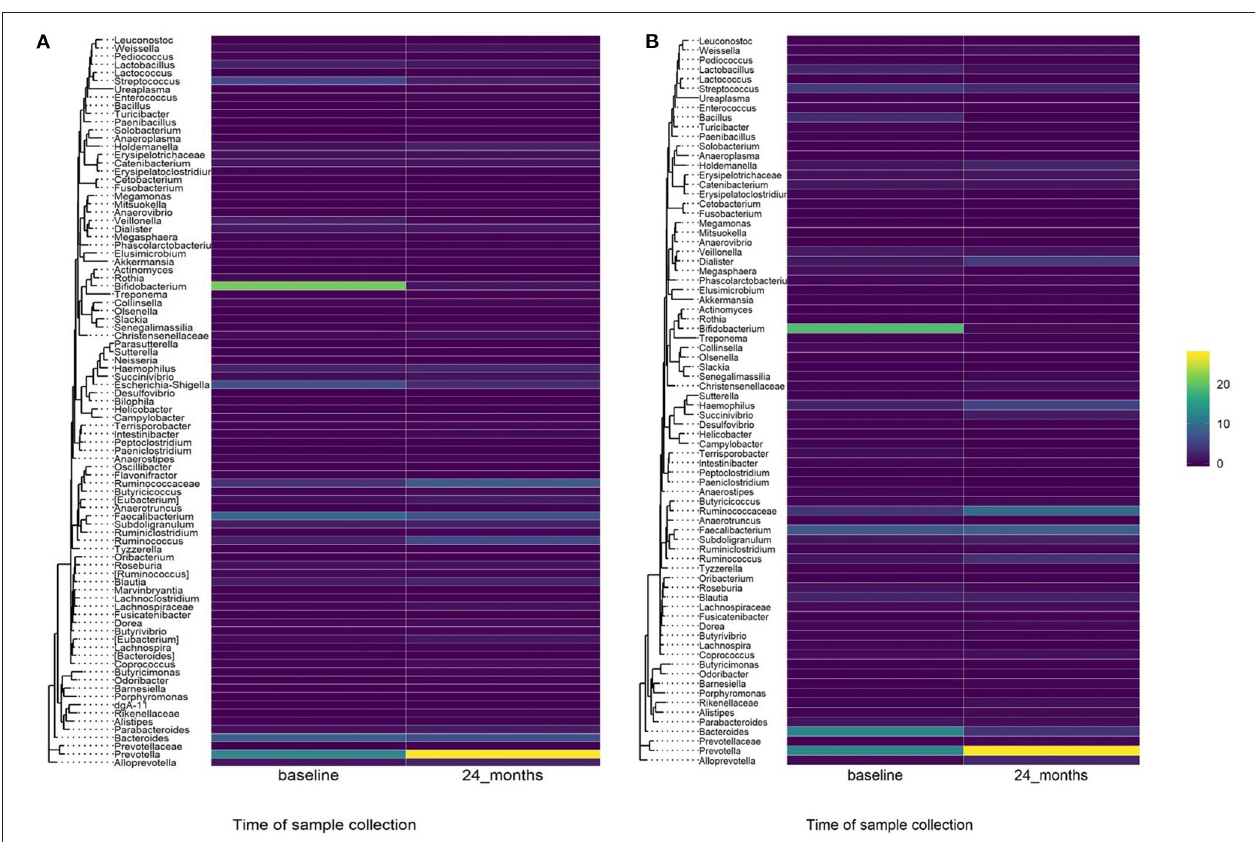
FIGURE 4 | Heatmap showing relative abundance of genera in baseline and 24-month fecal samples by treatment arm. (A) Azithromycin arm, (B) Placebo